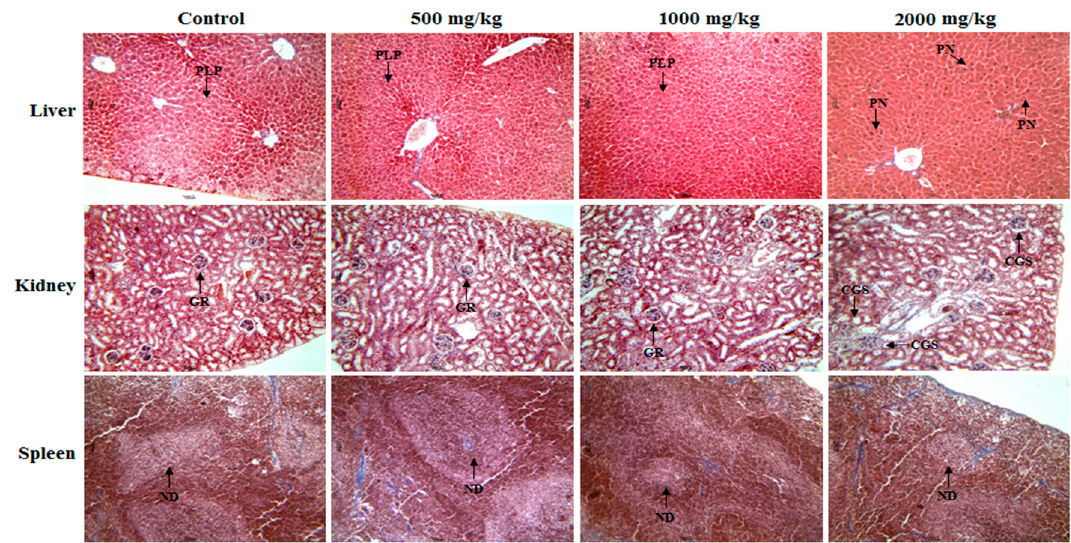
Figure 3. Representative photomicrographs of the livers, kidneys, and spleens of control mice (oral saline) and those treated with PS-UA (500, 1000, and 2000 mg / kg; oral administration). The liver with preserved liver parenchyma (PLP) and without significant histopathological changes compared with in the treatment of 2000 mg / kg, the liver presented pyknotic nucleus (PN). Kidneys: Renal glomeruli (GR) and contorted tubules without changes are visible in the control and groups treated with PS-UA at the 500 and 1000 mg / kg doses, while in the 2000 mg / kg treatment, the kidneys showed changes in the glomerular space, with morphological distortions. Spleen: The lymphatic nodes (ND) are well-defined in the control and treated groups. Hematoxylin and eosin staining was used. All images are with 100 × magnification.